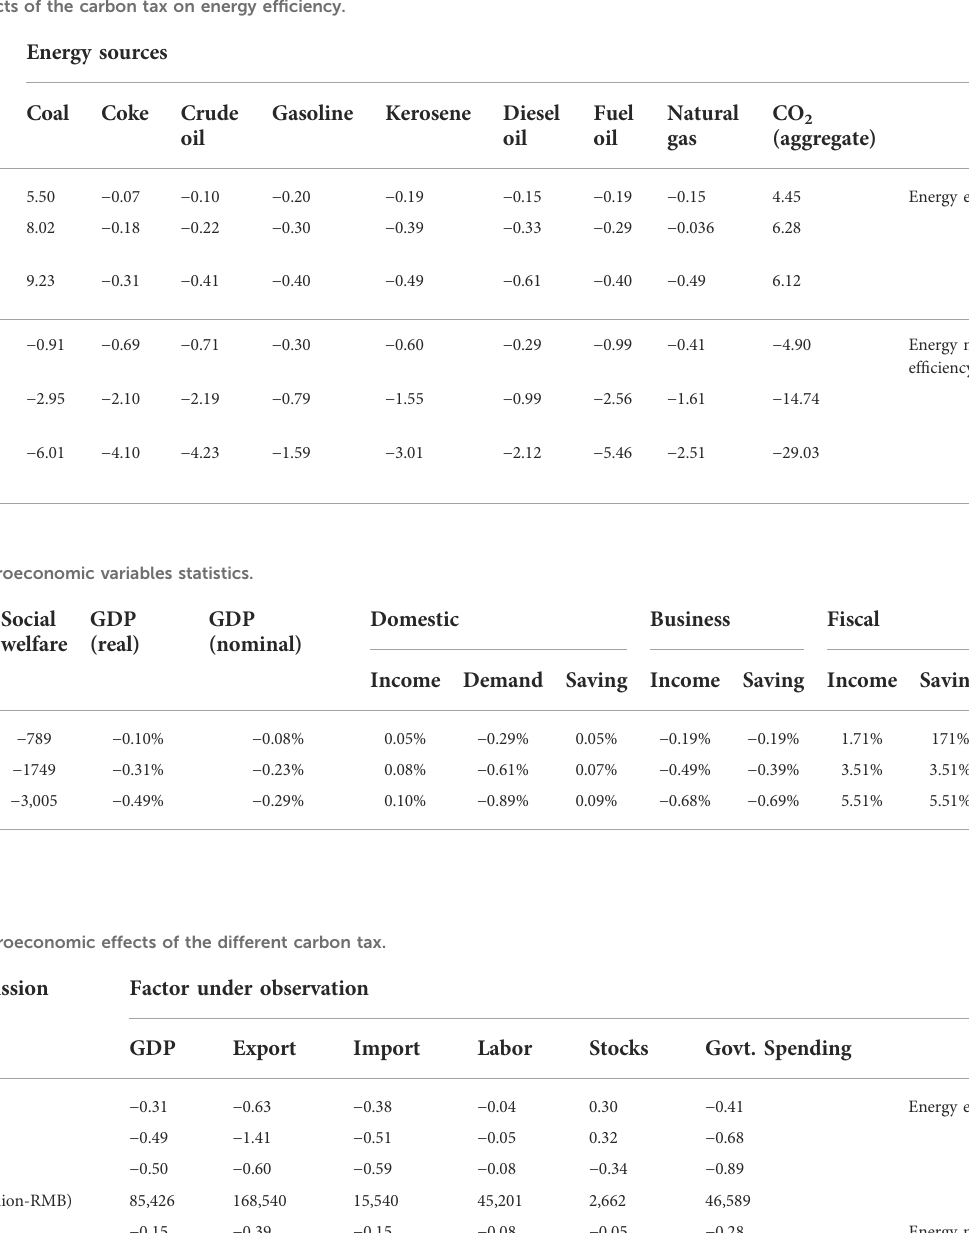
TABLE 4 Effects of the carbon tax on energy ef fi ciency.